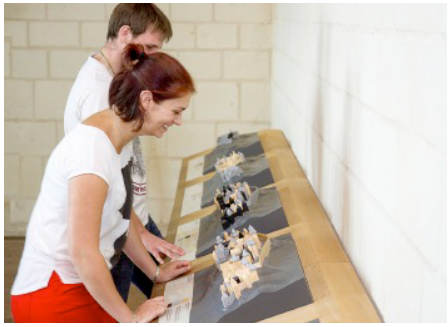
Figure 5 . Model of the Royal Fortress of Chinon dedicated to visually impaired visitors (https://www.ch-